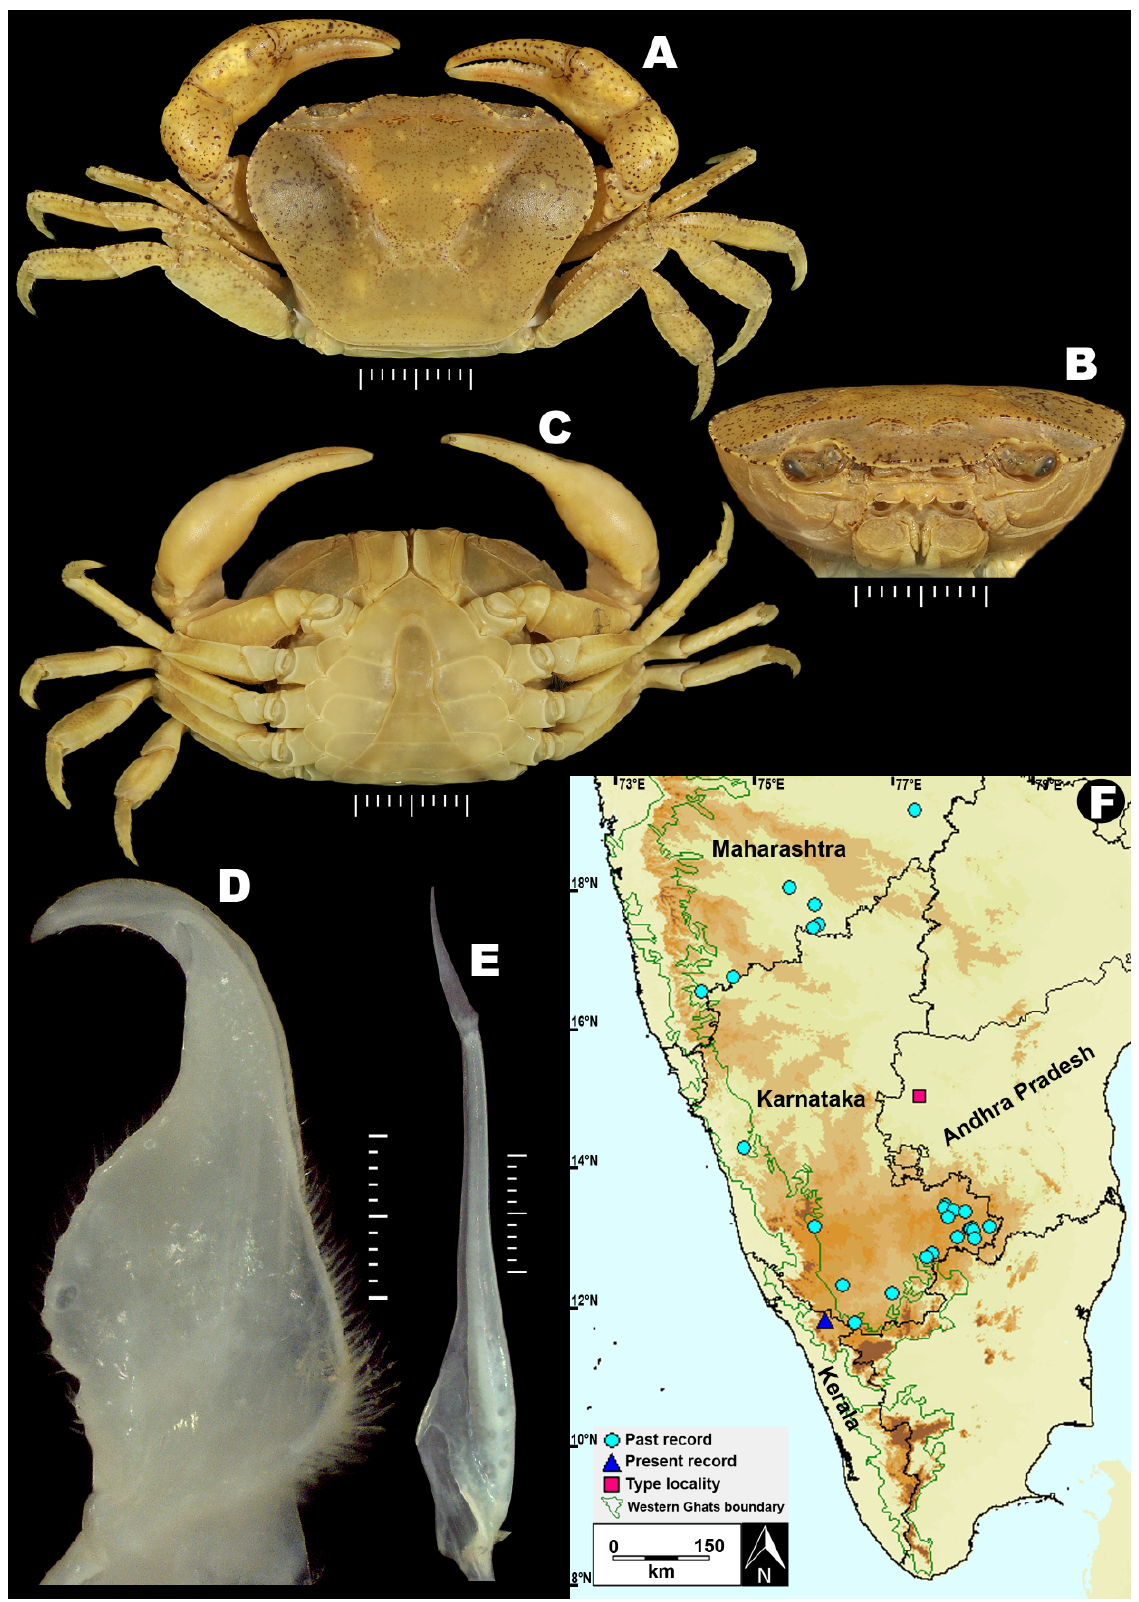
Figure 1. Oziotelphusa wagrakarowensis (Rathbun, 1904), male (29.18 × 20.76 mm) (ZSI-WRC C.1830). A, overall dorsal view; B, frontal view of cephalothorax; C, overall ventral view; D, dorsal view of left G1; E, left G2; F, map showing distribution of O. wagrakarowensis in the Indian peninsula. Scale bar = 10 mm (A–C), 1 mm (D,